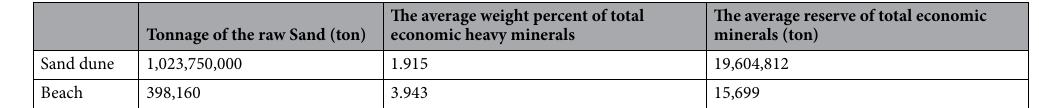
The average reserve of total economic minerals (ton)